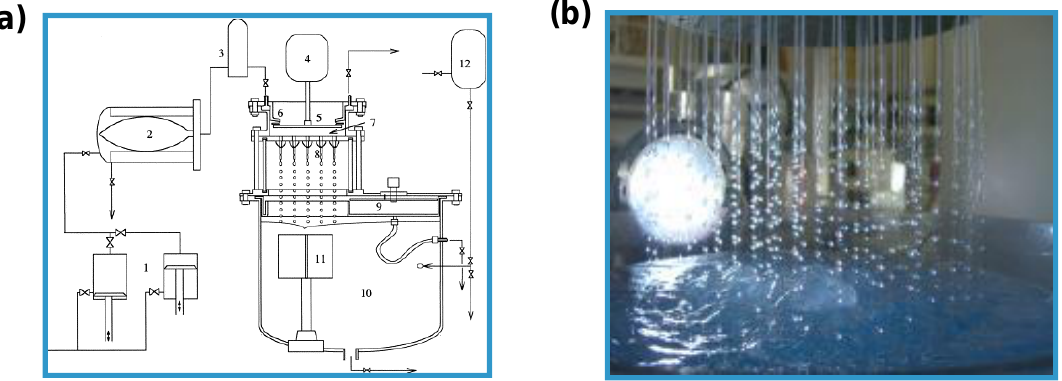
Figure 5. ( a ) Schematic illustration representing a multi-nozzle encapsulator (1, double piston pump; 2, sterile barrier; 3, damper; 4, vibrator; 5, membrane of pulsation chamber; 6, concentric split; 7, pulsation chamber; 8, nozzle plate; 9, bypass system; 10, reaction vessel; 11, stirrer; and 12, input hardening solution). Reprinted from [26] with permission from Elsevier. Copyright (1998). ( b ) Picture showing the equipment supplied by Brace GmbH (https://www.brace.de).